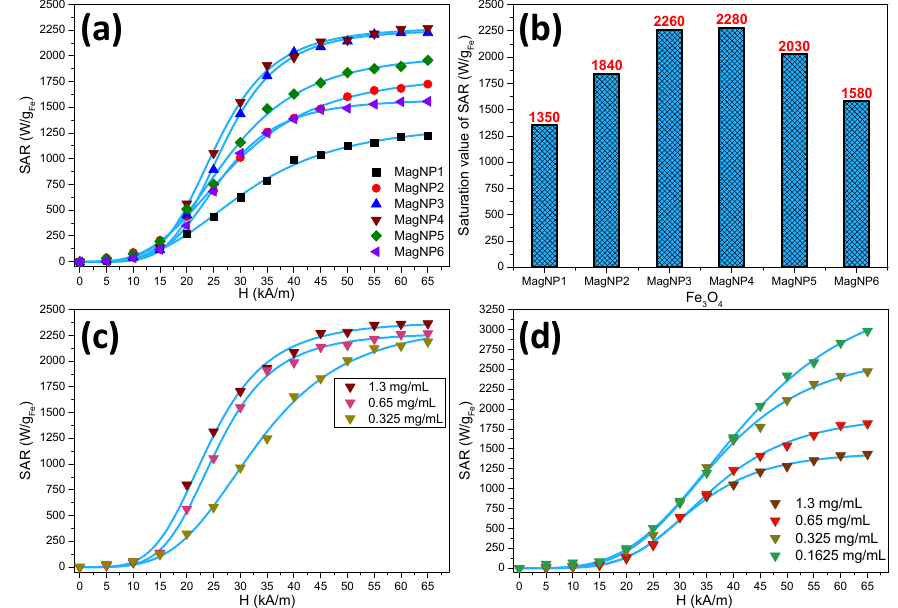
Figure 4. ( a ) Specific Absorption Rate (SAR) dependence on H for all six types of MNPs dispersed in water at an iron content of 0.65 mg / mL. ( b ) The value of SAR max for all six types of MNPs; SAR dependence on H for MagNP4 dispersed in ( c ) water and ( d ) solid PEG8K at different iron contents. Blue lines represent the fits with the logistic function.